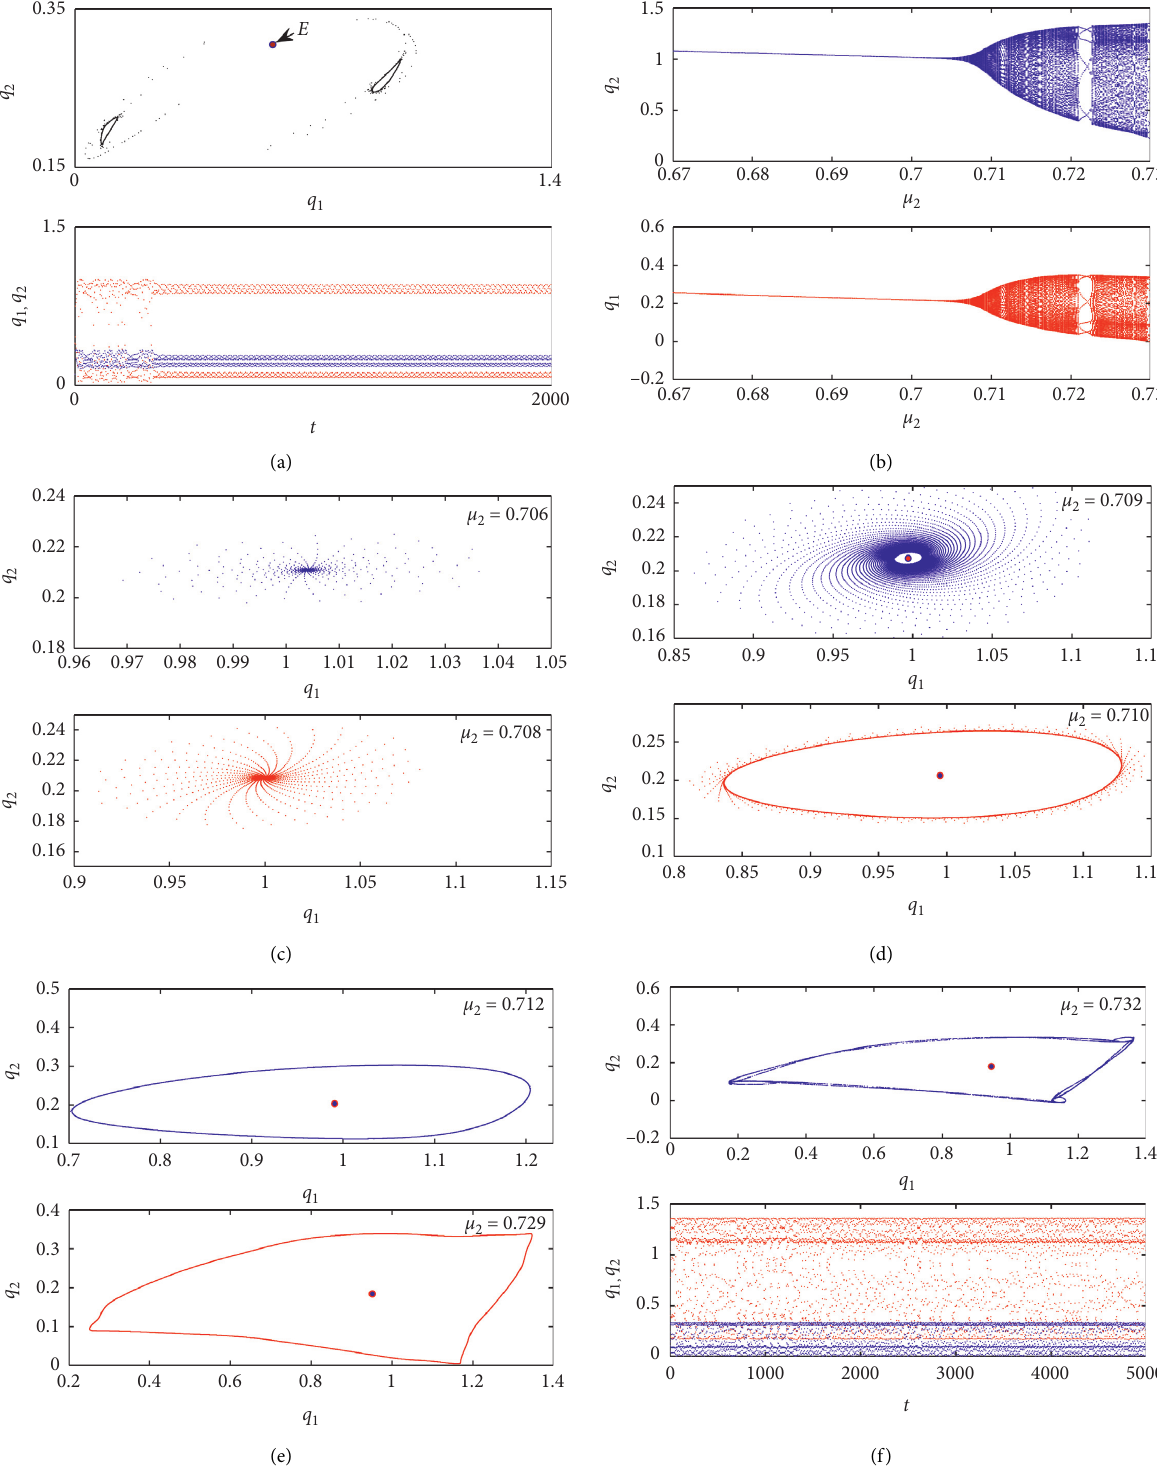
,q ) � ( 0 . 40 , 0 . 11 ) ,c 0 , 1 0 , 2 and q corresponding to these two invariant curves are also shown. (b) Bifurcation diagrams of q 1 2 . (c–f) Different behaviors of the map at different values of the bifurcation parameter μ 2